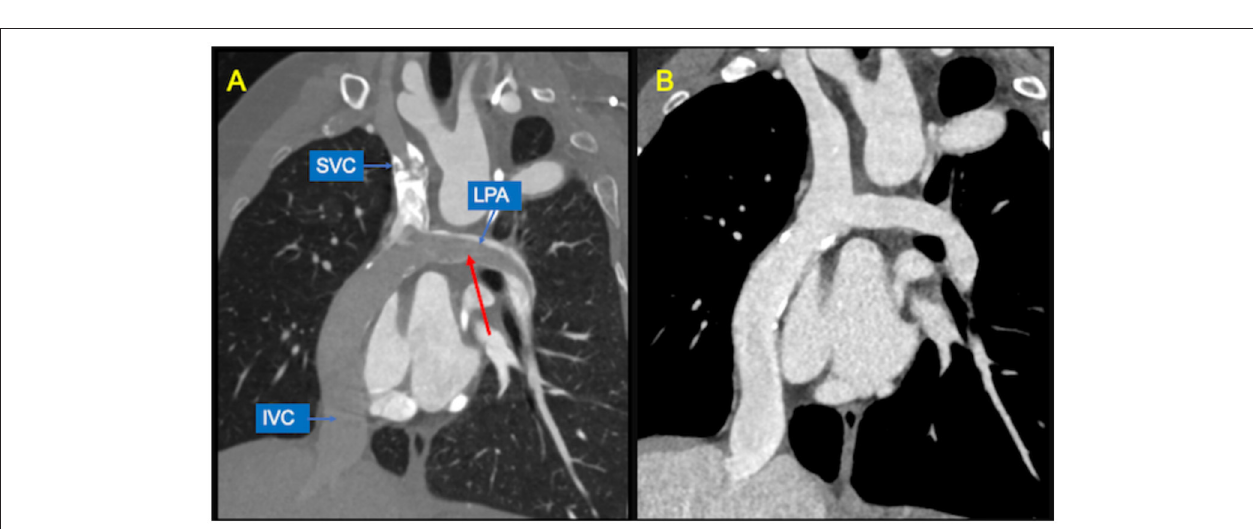
FIGURE 7 | Potential pitfalls of CCT with single-injection protocol. (A) Coronal image shows mixing of contrast material from the superior vena cava (SVC) and unopacified blood from inferior vena cava (IVC), generating pseudo-filling defects in the left pulmonary artery (LPA) during the early arterial phase (red arrow). (B) The same image obtained during venous recirculation of contrast reveals regular patency of the Fontan